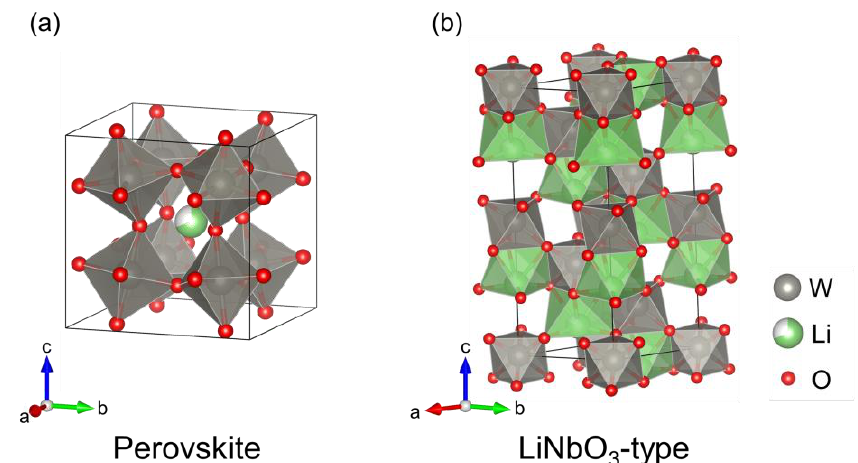
Figure 1. Crystal structures of Li x WO 3 for ( a ) 0 ≤ x < 0.5 with the cubic perovskite ( Im − 3) structure reported previously [8] and ( b ) 0.5 ≤ x ≤ 1 with the LiNbO 3 -type ( R 3 c ) structure obtained in this work. The grey, green and red balls represent W, Li and O atoms, respectively. W- and Li-centered octahedra are shown in grey and green.